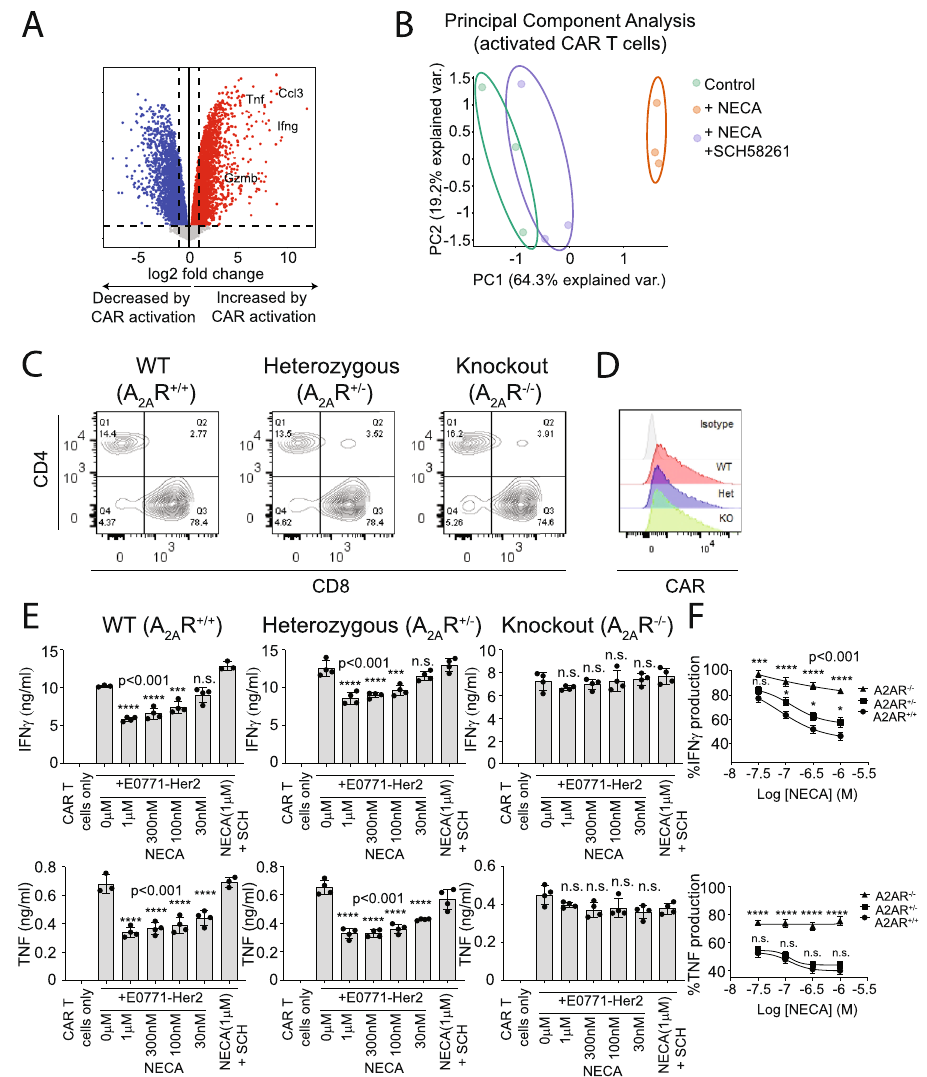
Fig. 1 A 2A R stimulation signi fi cantly modulates the CAR T-cell transcriptome in a partially gene-dose-dependent manner. A , B Anti-Her2 CAR T cells were generated from WT mice and after 7 days of culture in IL-2 (100 U/ml) and IL-7 (200 pg/ml) stimulated with plate-bound anti-myc Tag (anti-CAR) antibody in the presence or absence of NECA (1 µ M) or SCH58261 (1 µ M) for 8 h. Cells were then analyzed by 3 ′ RNA-Seq. A Differential gene expression analysis, color indicates genes that are signi fi cantly upregulated (red) or downregulated (blue) following activation through the CAR. Statistical tests were performed with indicated R packages as outlined in “ Methods ” . B Principal component analysis based on top 100 most variably expressed genes. C – E Anti- Her2 CAR T cells were generated from A 2A R + / + (wild type; WT), A 2A R + / − , or A 2A R − / − mice as per ( A ). C , D Expression of ( C ) CD8, CD4, and ( D ) anti- Her2 CAR. E , F 1 × 10 5 anti-Her2 CAR T cells were cocultured with E0771-Her2 for 16 h in the presence or absence of SCH58261 (1 µ M) and/or indicated concentrations of NECA. E Data represent the mean ± SD of triplicate/ quadruplicate cultures from a representative experiment of n = 3. Statistics indicate signi fi cance relative to 0 µ M NECA condition. F Percentage production of IFN γ and TNF relative to the control condition for each genotype. The results were calculated from pooled data of n = 3 experiments presented as mean ± SEM. Nonlinear regression analysis. E , F Statistics indicate signi fi cance relative to wild-type values as calculated by a one-way ANOVA and Tukey ’ s post hoc test (adjusted for multiple comparisons). Source data are provided as a Source Data fi